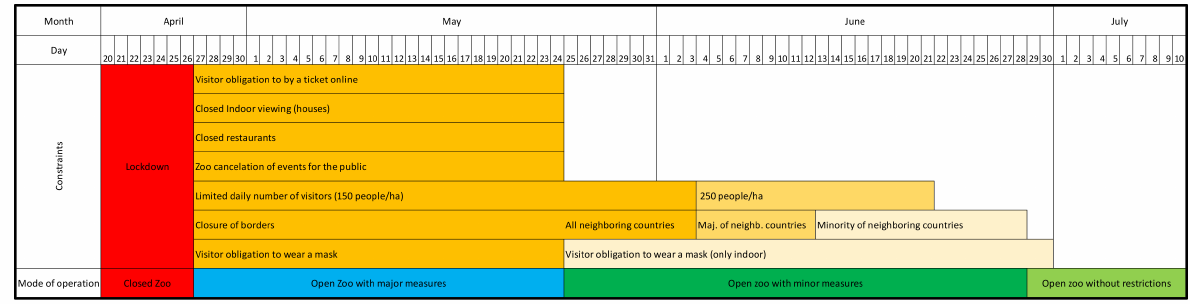
Figure 1. Timeline of the mode of zoo operation and Czech restrictive measures during COVID-19 in spring